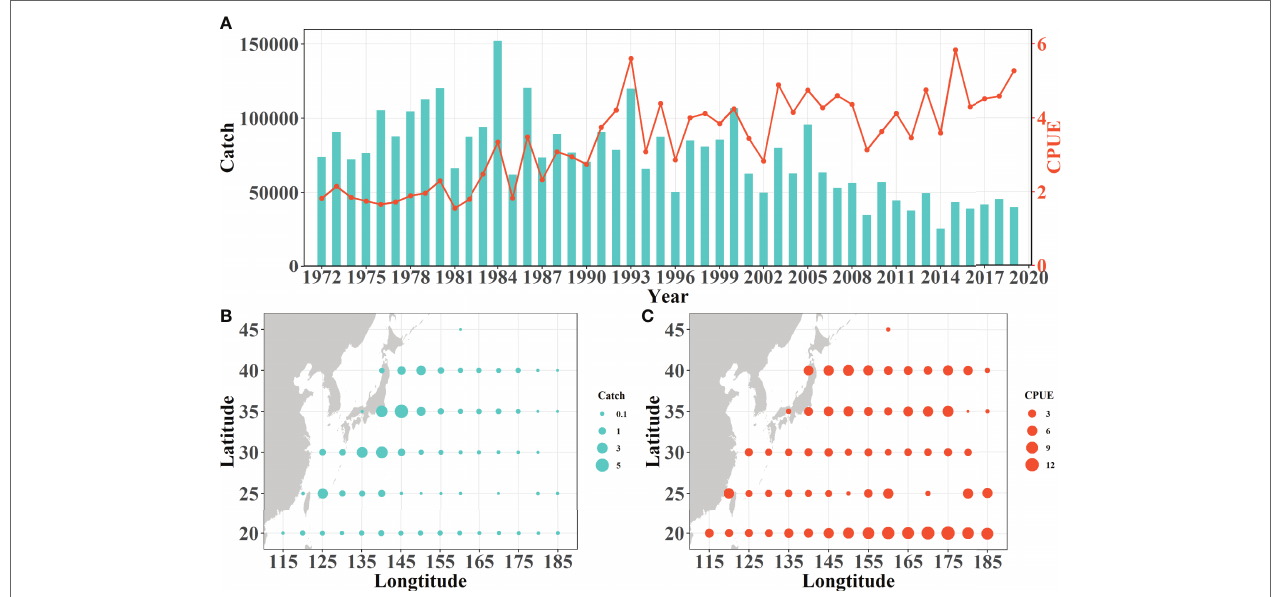
FIGURE 3 | Characteristics of temporal variations and spatial distributions of skipjack tuna in the study area during 1972–2019. (A) Timeseries variations of skipjack catch (blue lake bar) and CPUE (bright orange line). (B) Spatial distribution of skipjack accumulative catches (million metric tons). (C) Spatial distribution of skipjack mean CPUE (metric tons per day).